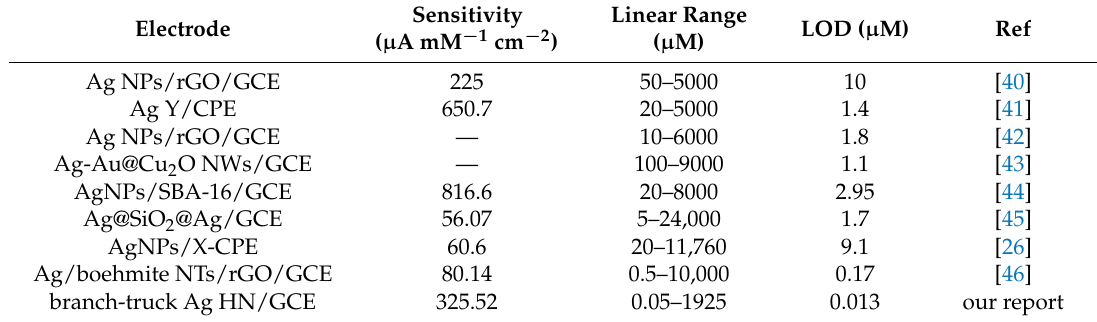
Table 1. Comparison of the fabricated sensor with other Ag material-based non-enzyme sensors for H 2 O 2